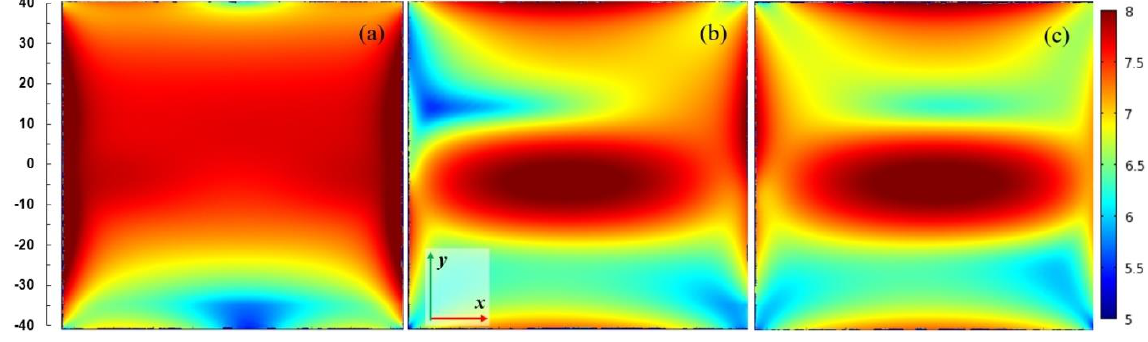
Figure 9. Spatial distributions of the log 10 of Q rh /(1 Wm −3 ) in the x - y plane passing through the center of the plasma for P ent = 100 W. ( a ) L = 15 mm, ( b ) L = 25 mm, and ( c ) L = 35 mm. The scale on the left shows dimensions in mm.